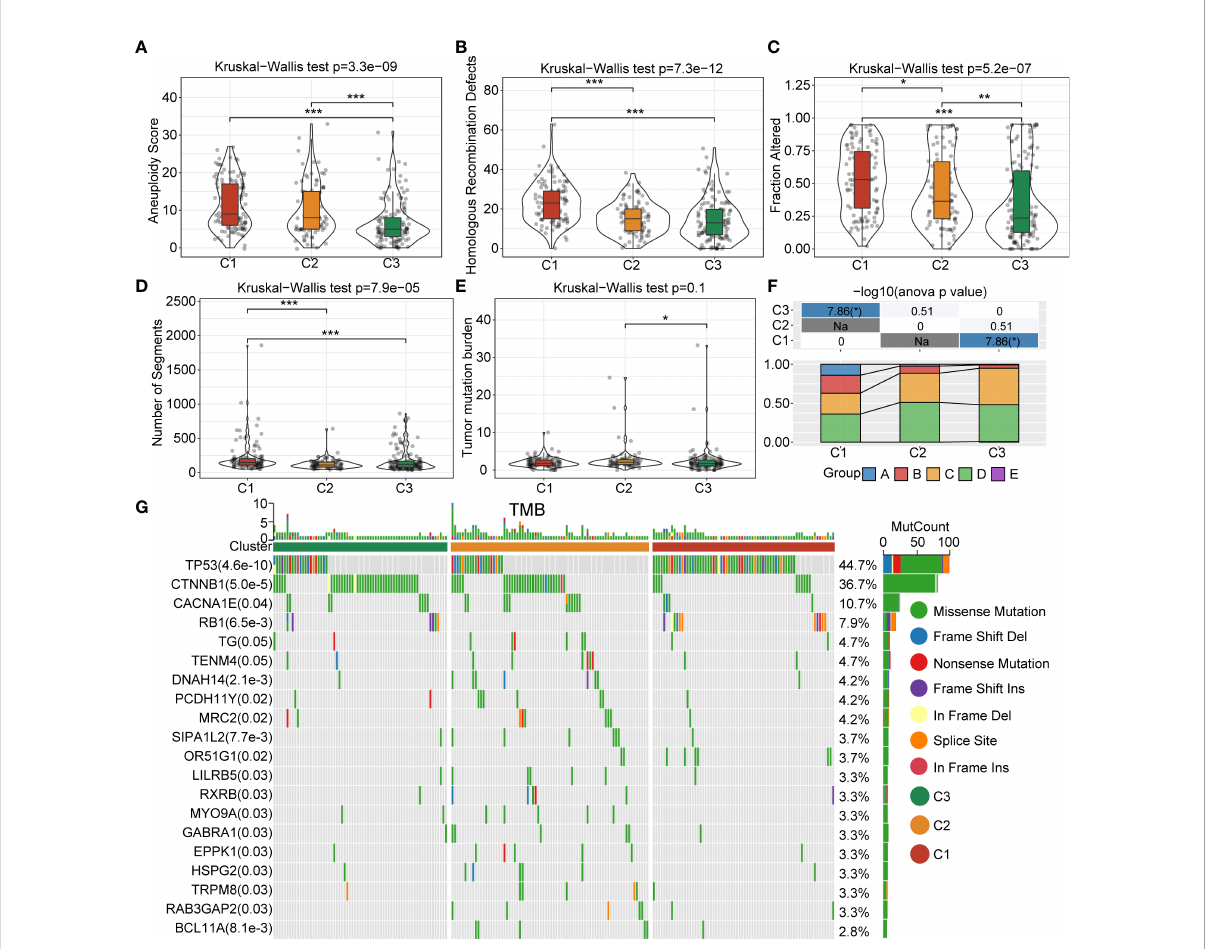
FIGURE 3 Landscapes and genomic mutation features between C1, C2 and C3 in the TCGA-LIHC cohort. (A) Aneuploidy score difference between 3 clusters. (B) Difference in homologous recombination defects between 3 clusters. (C) Fraction-altered percentage difference between 3 clusters. (D) Differences in the number of segments between 3 clusters. (E) Difference in the tumor mutational burden in 3 clusters. (F) Comparison of the proportions of three molecular subtypes and immune signature-based subtypes A – E clusters in the 3 clusters. (G) Somatic mutations in the three molecular subtypes (Chi-square test). *P<0.05; **P<0.01;